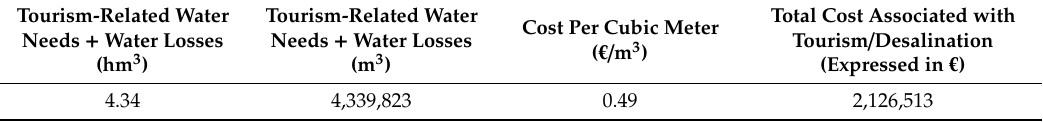
Table 8. Desalination cost,